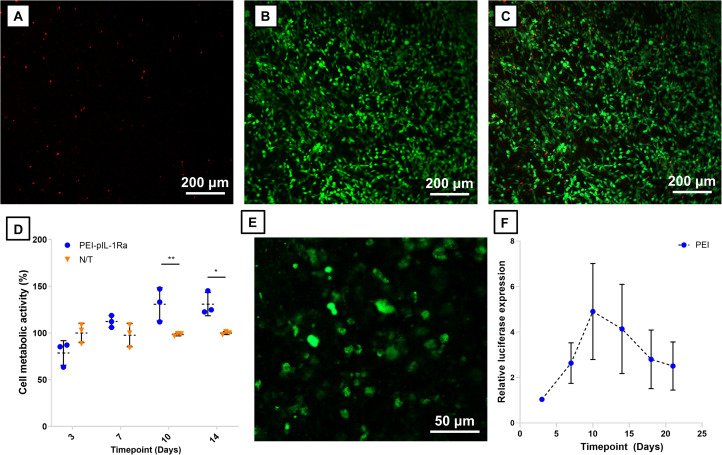
Assessment of BM-MSCs transfection in gene-activated CHA scaffolds. Cell viability of BM-MSCs in CHA scaffolds activated with PEI-pIL-1Ra nanoparticles after 3 days in culture is depicted in (A–C): (A) Dead cells (ethidium homodimer 1-positive), (B) live cells (calcein-positive), (C) Overlay of live and dead cells. (D) Metabolic activity of cells in CHA scaffolds without nanoparticles (non-transfected) and CHA scaffolds activated with PEI-pIL-1Ra nanoparticles (PEI) after 3, 7, 10, and 14 days. (E) GFP+ cells were observed in CHA scaffolds activated with PEI-pIL-1Ra nanoparticles 3 days post-transfection. (F) The transgene expression profile of luciferase in CHA scaffolds activated with PEI-pGLuc nanoparticles, normalized to luciferase expression 3 days post-transfection. *, **, and *** denotes p < 0.05, p < 0.01, and p < 0.0001, respectively. Data plotted represents mean ± standard deviation, n = 3.